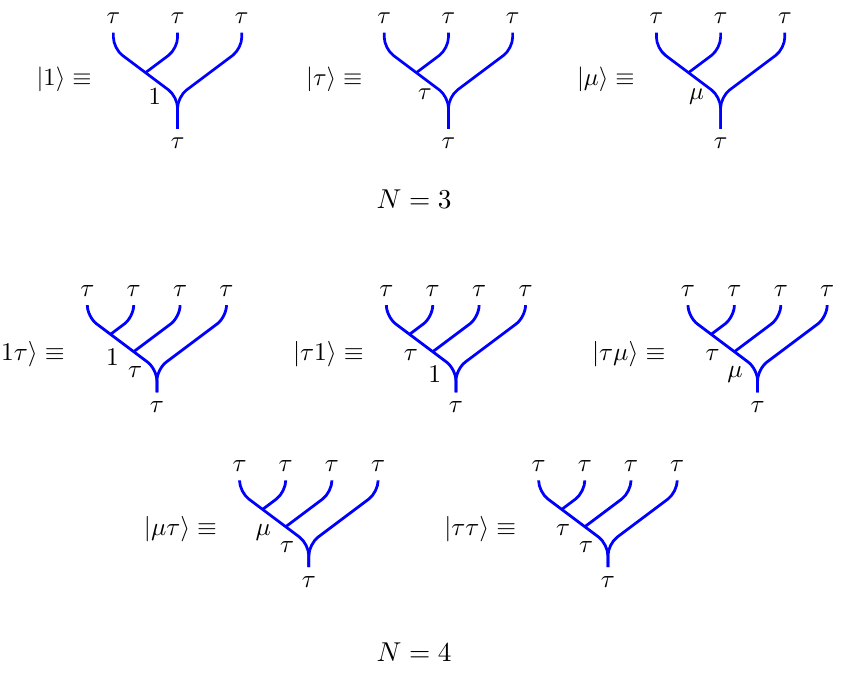
Figure 7 . Fusion basis resulting from the fusion of N = 3 and N = 4 Jones-Kauffman anyons. admissible fusion sequence of length l + 1 starting with τ . Therefore f